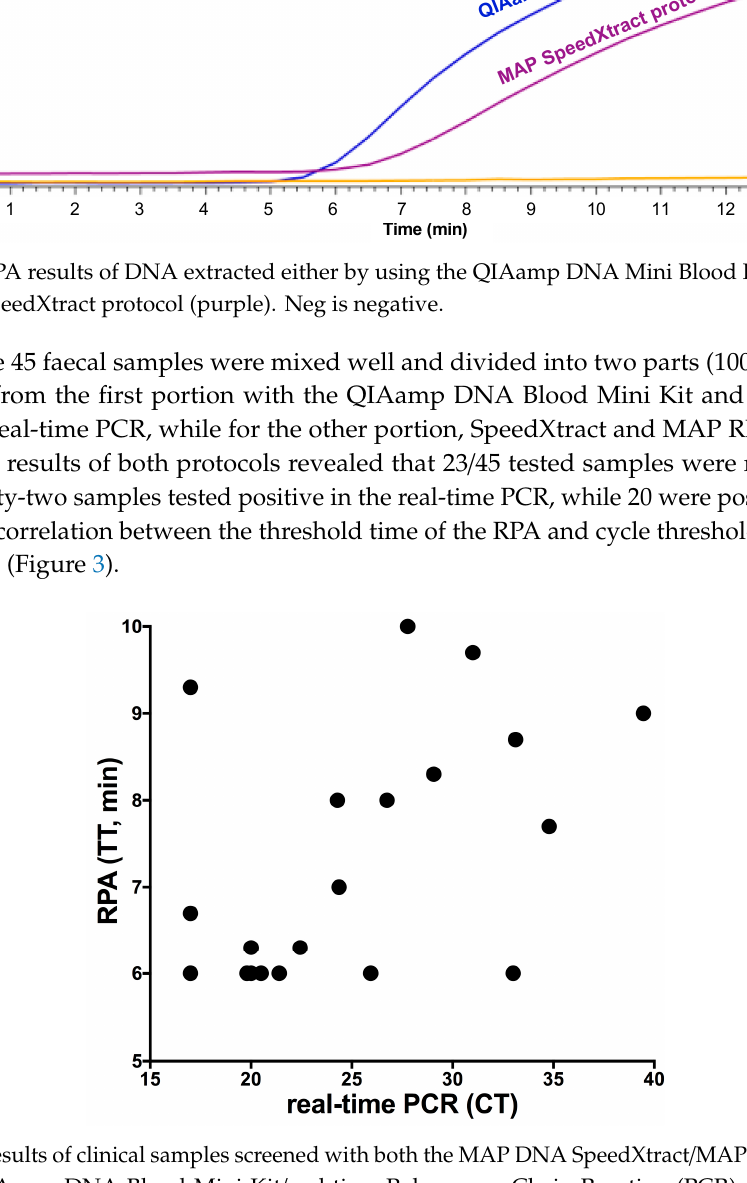
Figure 1. Workflow of the rapid point of need Mycobacterium avium subspecies paratuberculosis (MAP) extraction protocol. The procedure combines bead beating together with the basic SpeedXtract method. It represents protocol number 10 in Table 1.